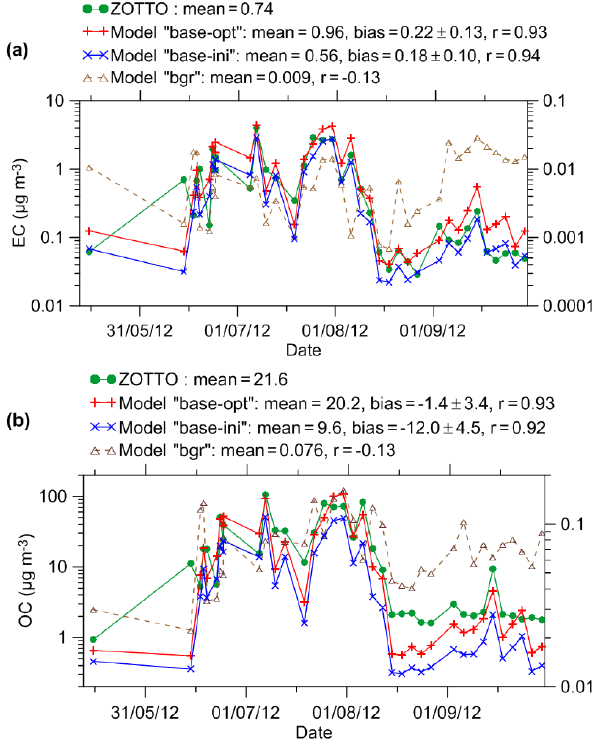
Figure 9. CO mixing ratios (ppb) derived from the measurements that were made in the framework of the YAK-AEROSIB experiment on 31 July and 1 August 2012 (a) in comparison with the corre- sponding simulated values from the “base-opt” CHIMERE run (b) . The mixing ratios are overlaid on the CHIMERE grid; the mixing ratio values were calculated by averaging the original measurement data and their simulated matchups over the region covered by each grid cell that was intersected by the aircraft